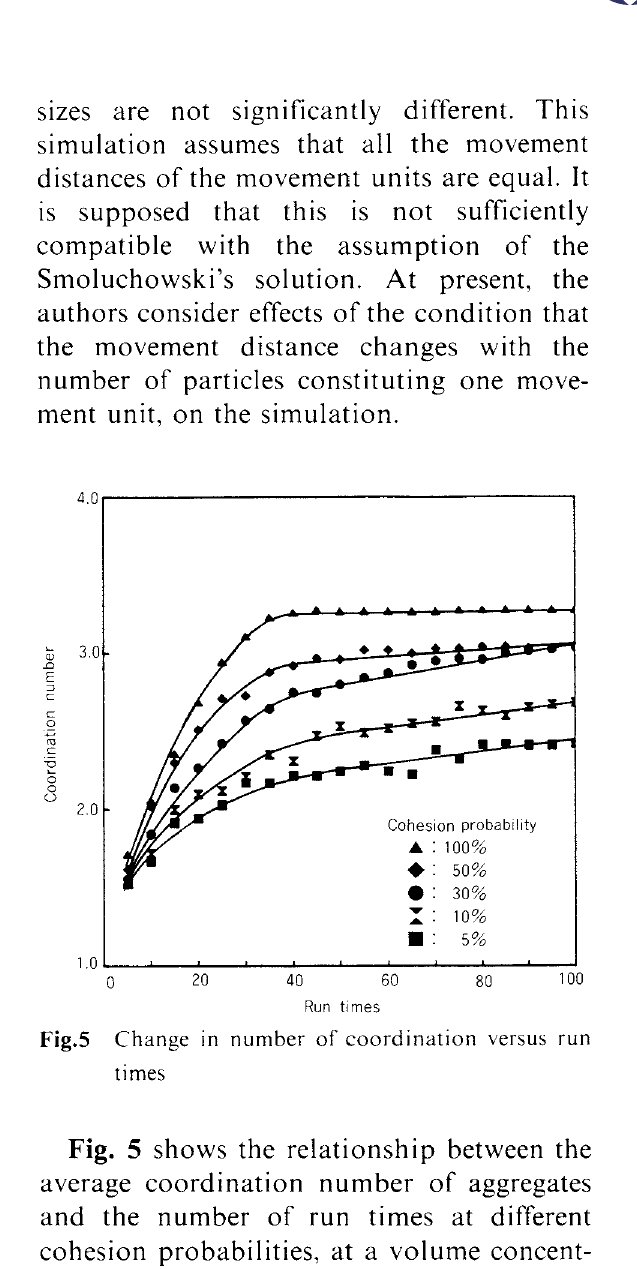
Fig.S Change in number of coordination versus run times Fig. 5 shows the relationship between the average coordination number of aggregates and the number of run times at different cohesion probabilities, at a volume concent ration of particles of 42 vol. %. The average coordination number is the average number of coordinating particles in the aggregates excluding aggregates with a coordination number of 0, that is, the dispersed particles. At any of the cohesion probabilites, the average coordination number increases with the numbers of run times. Particularly, in